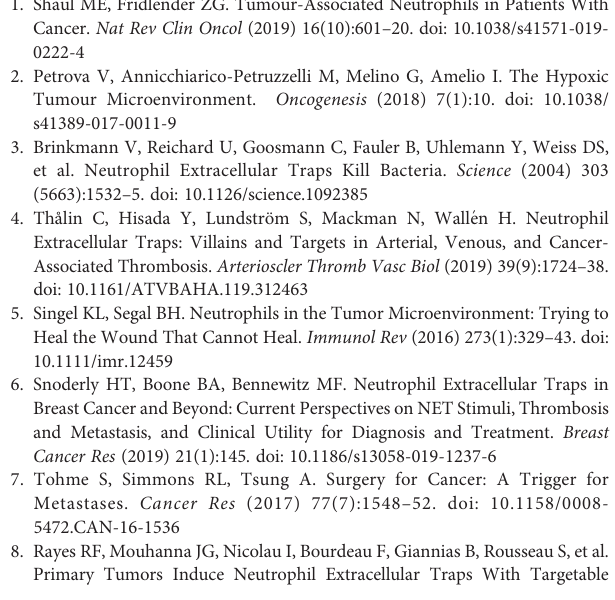
Supplementary Figure 1 | (A) Neutrophils from healthy or postoperative patients were treated with PMA and stained for cit-H3 and PD-L1, respectively. Co- localizationofcit-H3andPD-L1areindicatedbywhitearrows. (B, C) CD4 + orCD8 + T cells were isolated from healthy individuals, cocultured with NETs from healthy volunteer donors or postoperative patients and stained for markers of exhaustion. (D) Exhaustion surface marker expression levels were determined on naïve splenic CD4 + TcellsafterculturewithWTNETsorWTNETs+DNAseusing fl owcytometry. (n=3). Bar graphs represent mean +/- SEM of two independent experiments (A/C), *p < 0.05, **p <